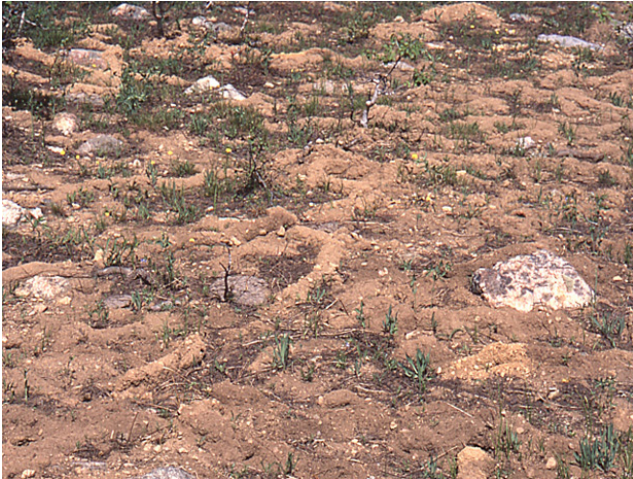
Figure 17. Pocket gopher ‘eskers’ (snow tunnel fillings) in the treeline ecotone, Colorado Front Range at about 3350 m. Photo taken by F.-K. Holtmeier, 25 July 1989.